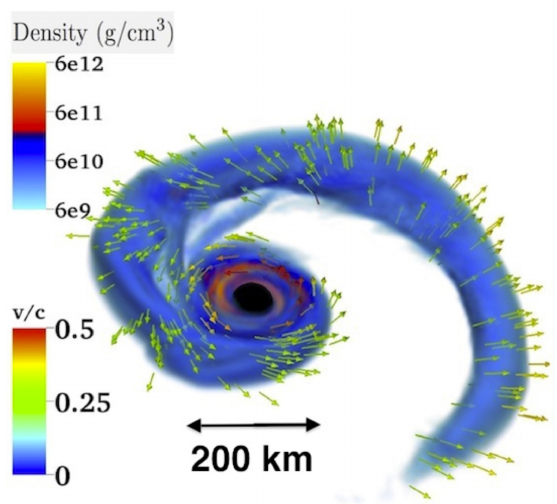
Figure 2. Numerical simulation of matter distribution during tidal disruption of a neutron star in neutron star-black hole merger: a significant portion of the remnant material is unbound [22].